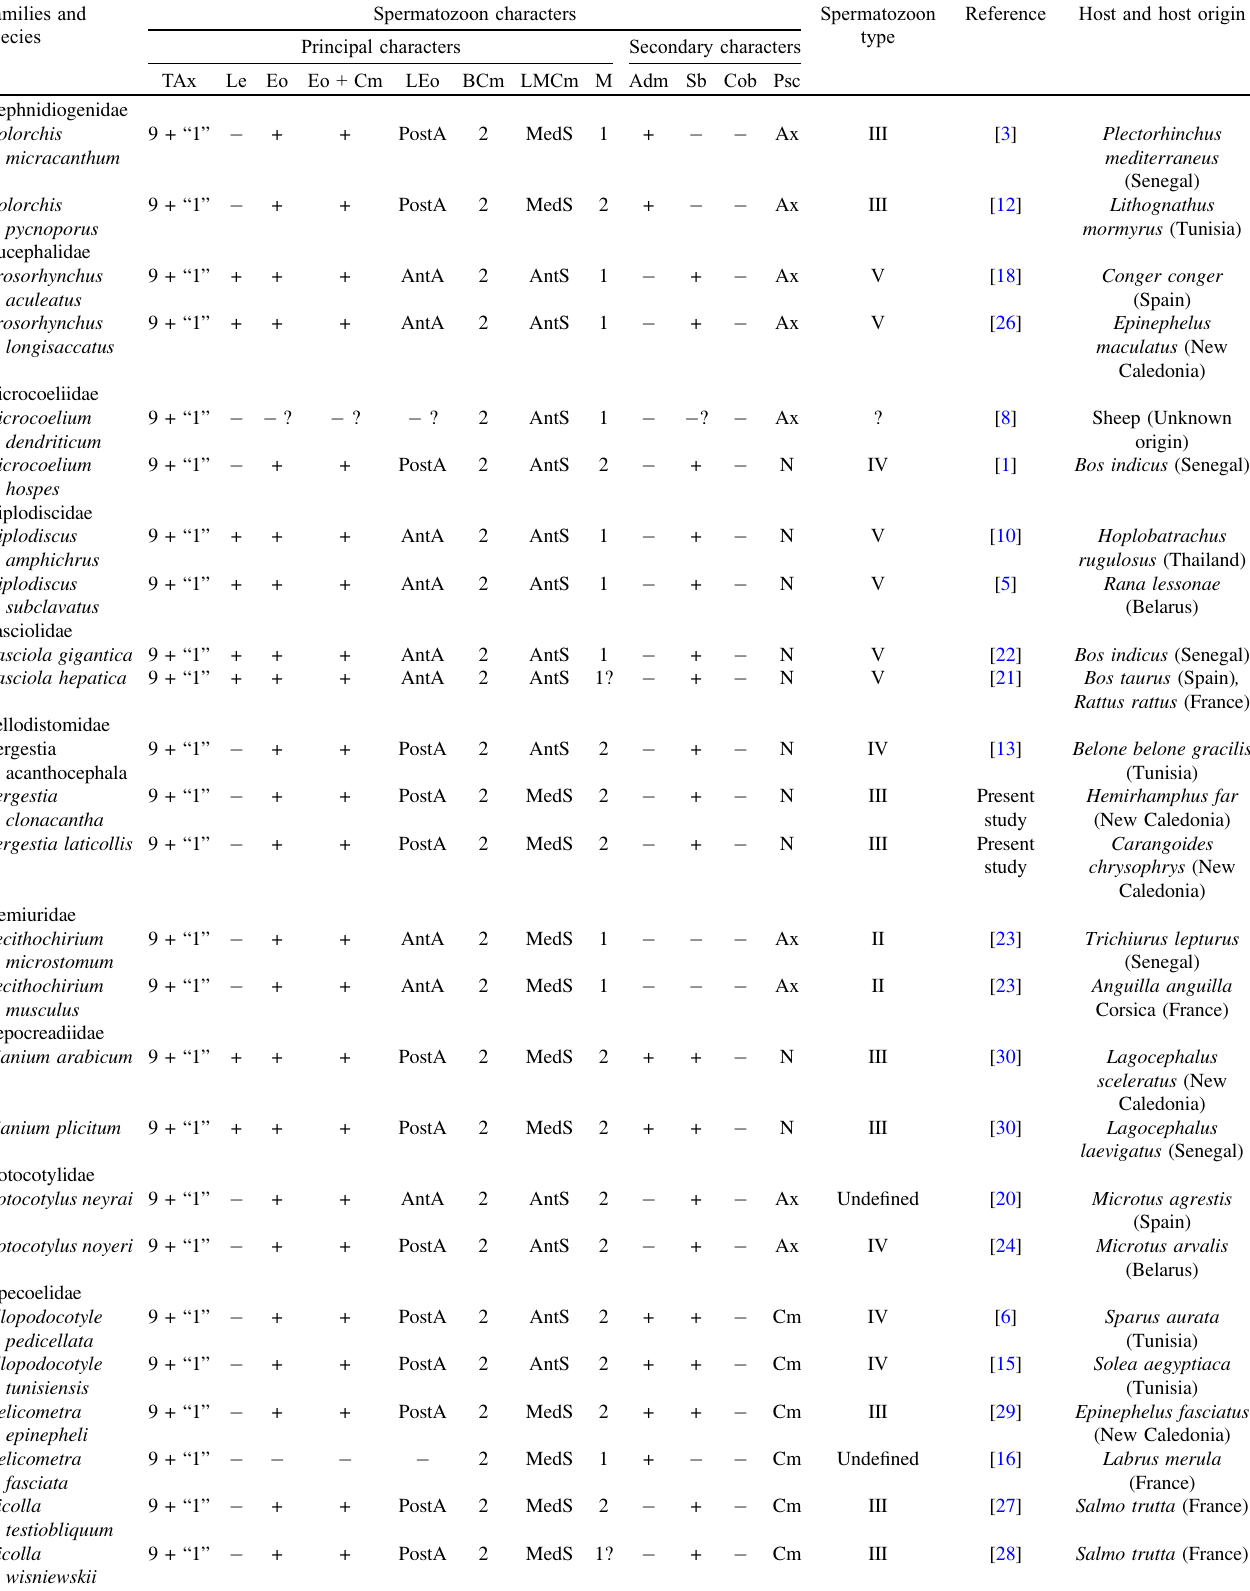
Table 1. Comparative data on the ultrastructure of the mature spermatozoon in some digeneans of the same genus and their origins. Families and